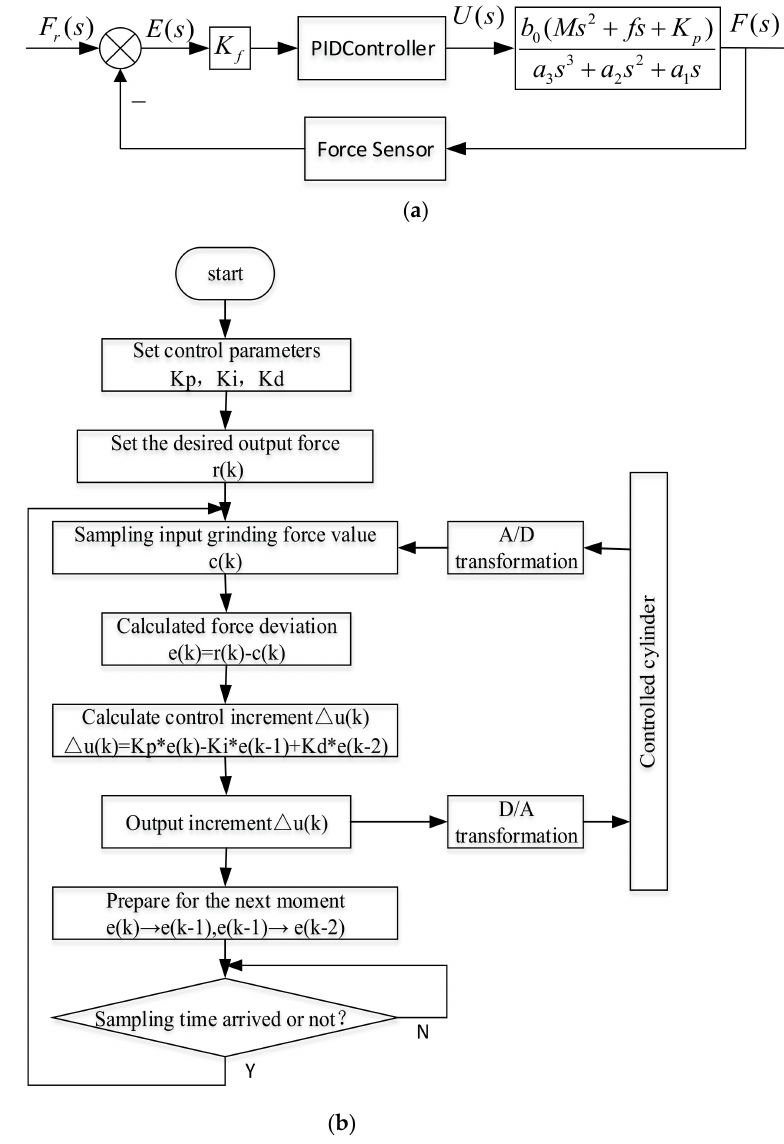
Figure 15. Diagram of a PID control system. ( a ) Block diagram of a PID control system; ( b ) Flow chart of a PID control